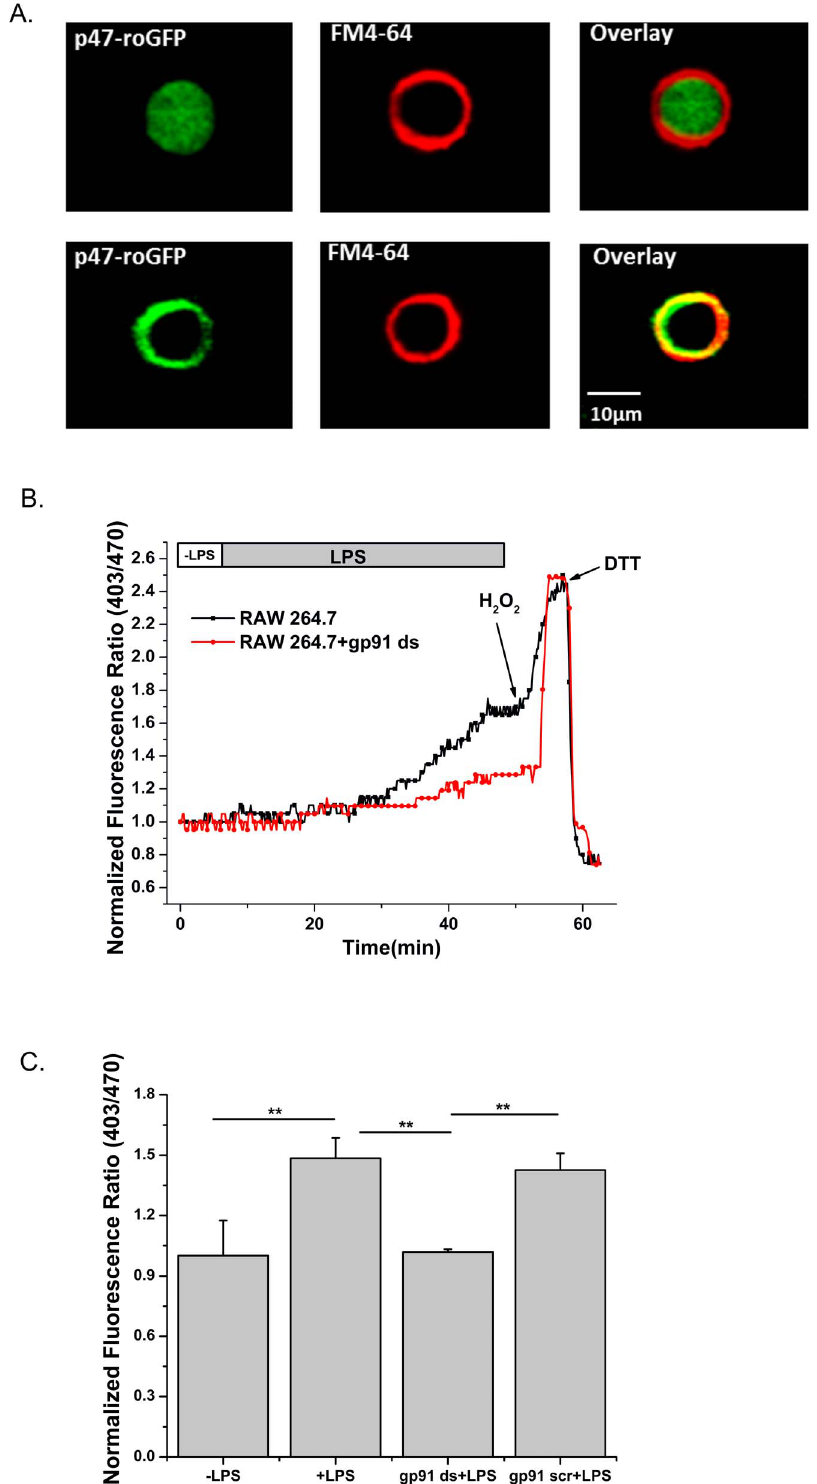
Figure 2. p47-roGFP allows for live-cell imaging of redox changes during RAW264.7 cell activation. ( A ) Representative confocal image of RAW264.7 cells transfected with p47-roGFP shows cytosolic distribution of p47-roGFP in control cells ( 2 LPS). Upon LPS-mediated activation (20 ng/ ml, 45 min) p47-roGFP localized with the membrane dye FM4-64 H . (B) Representative time course of LPS-induced p47-roGFP oxidation. Biosensor oxidization occurred dynamically upon LPS-induced activation (black squares), while in the presence of the Nox peptide inhibitor gp91ds (5 m m, 60 min) minimal oxidation occurred (red circles). After 45 min of LPS, cells were treated with 1 mM H 2 O 2 to maximally oxidize followed by addition of 10 mM DTT to maximally reduce the biosensors. (C) Average ( 6 SEM) of 9 cells for each condition from (B) during the last 3 minutes of LPS. ** p , 0.01 (Tukey statistical analysis for p value). doi:10.1371/journal.pone.0063989.g002 PLOS ONE |